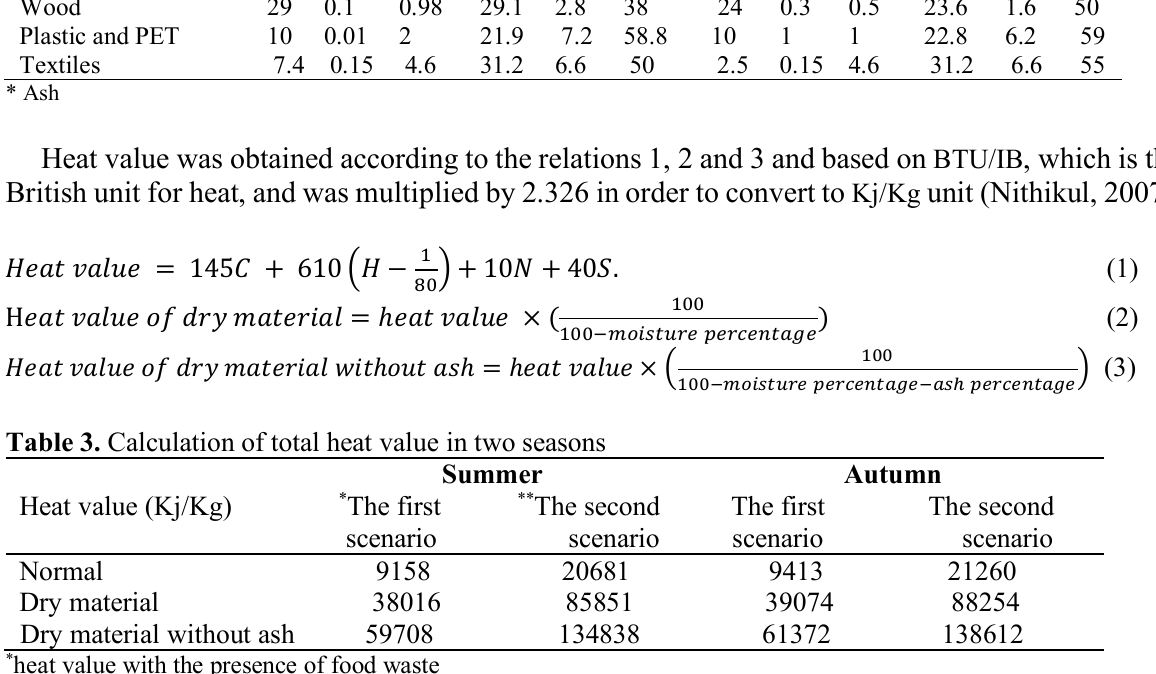
Table 2. The average weight percent of the elements and the percentage of ash of each waste component Waste components Corruptible material Wood Plastic and PET Textiles